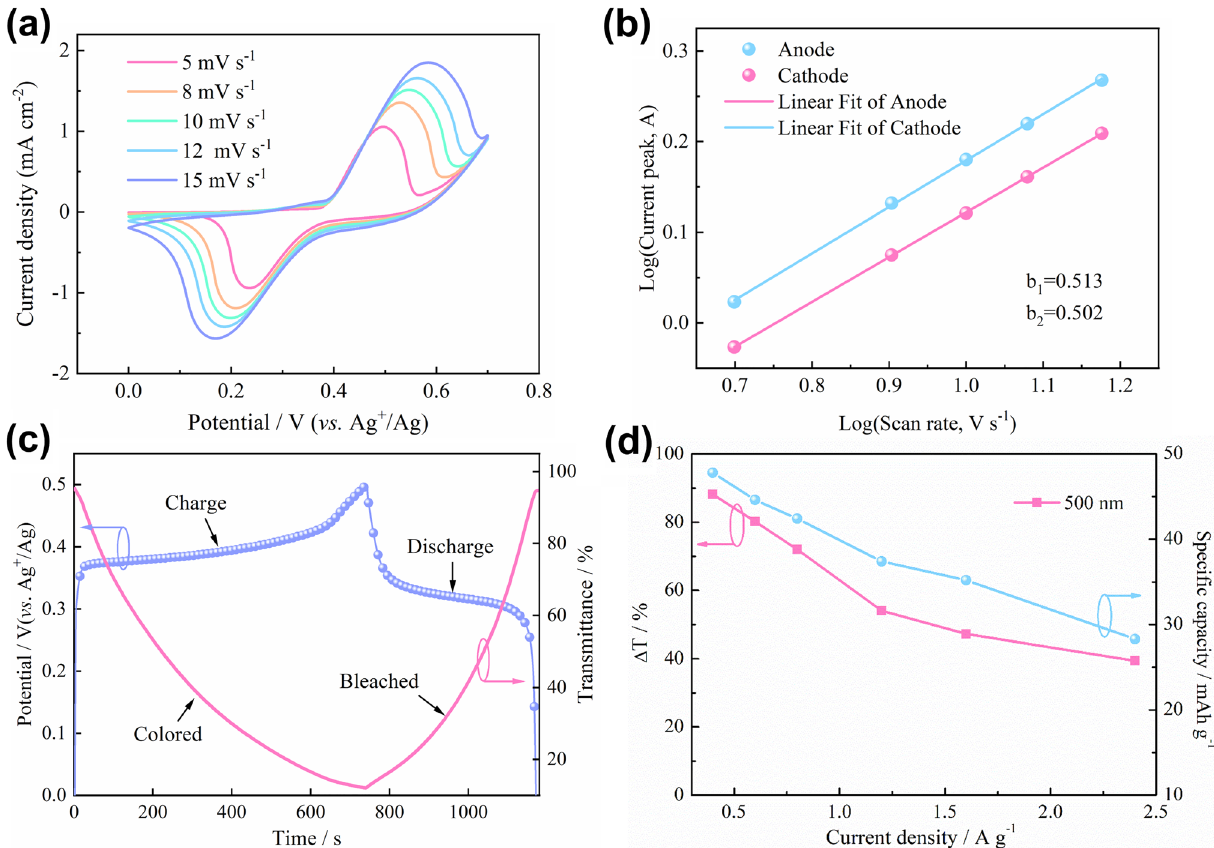
Fig. 3 a CV curves of NHP film at different scan rates from 5 to 15 mV s −1 between 0 and 0.7 V ( vs. Ag + /Ag). b Calculation of b value accord- ing to the relationship between log( v ) and log( A ) in the CV measurements of NHP film. c Galvanostatic charge–discharge profile at 0.4 A g −1 and corresponding in situ response spectrum at 500 nm of the NHP film. d Optical modulation and specific capacity of the NHP film as a func- tion of current